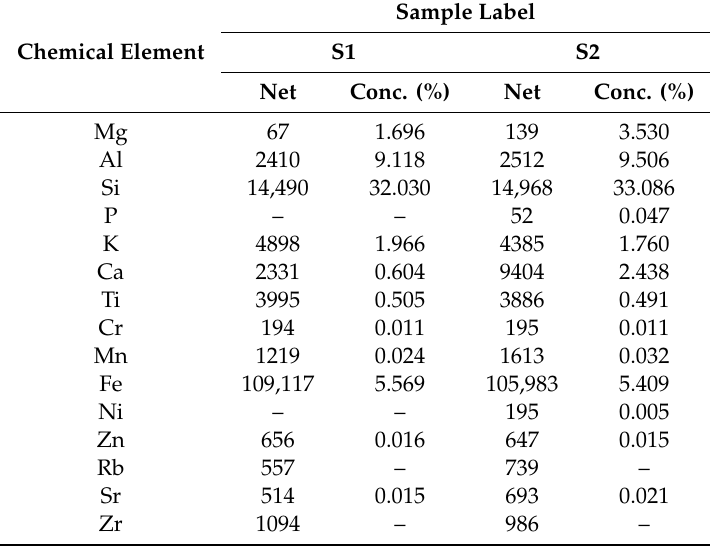
Table 1. Average values of the constituent elements in the samples of raw